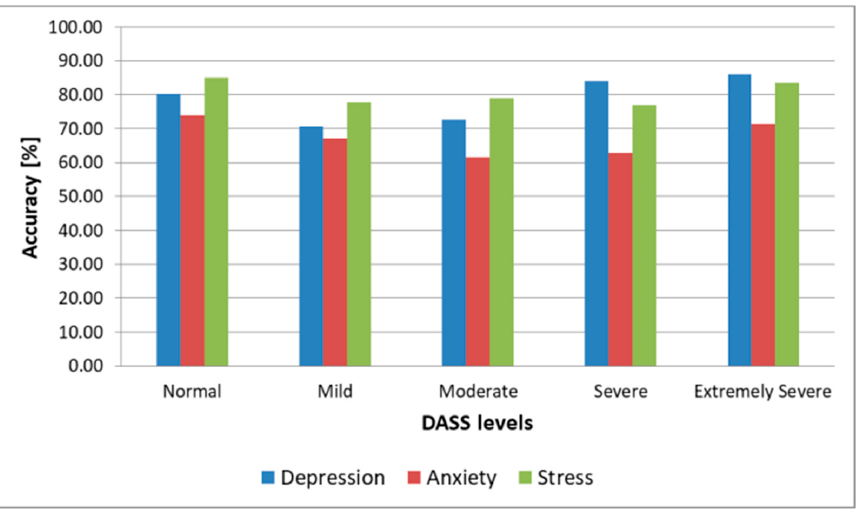
Figure 13. DASS levels prediction accuracy (intersubject methodology).